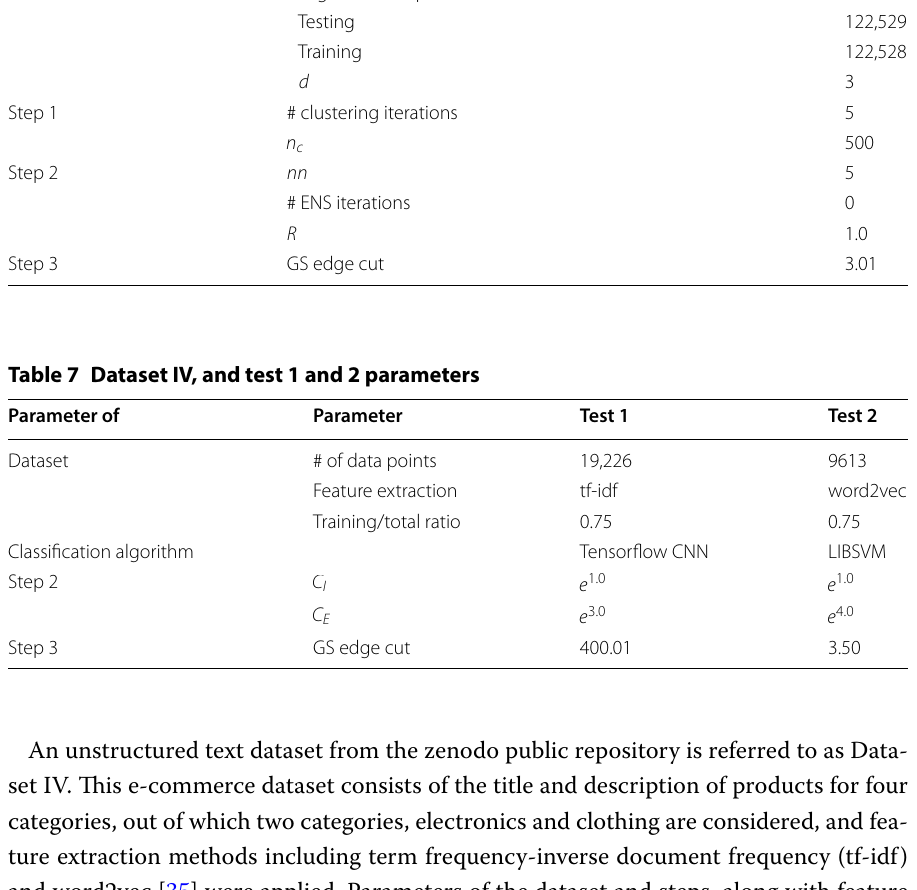
Table 6 Dataset III along with steps parameters Parameter of